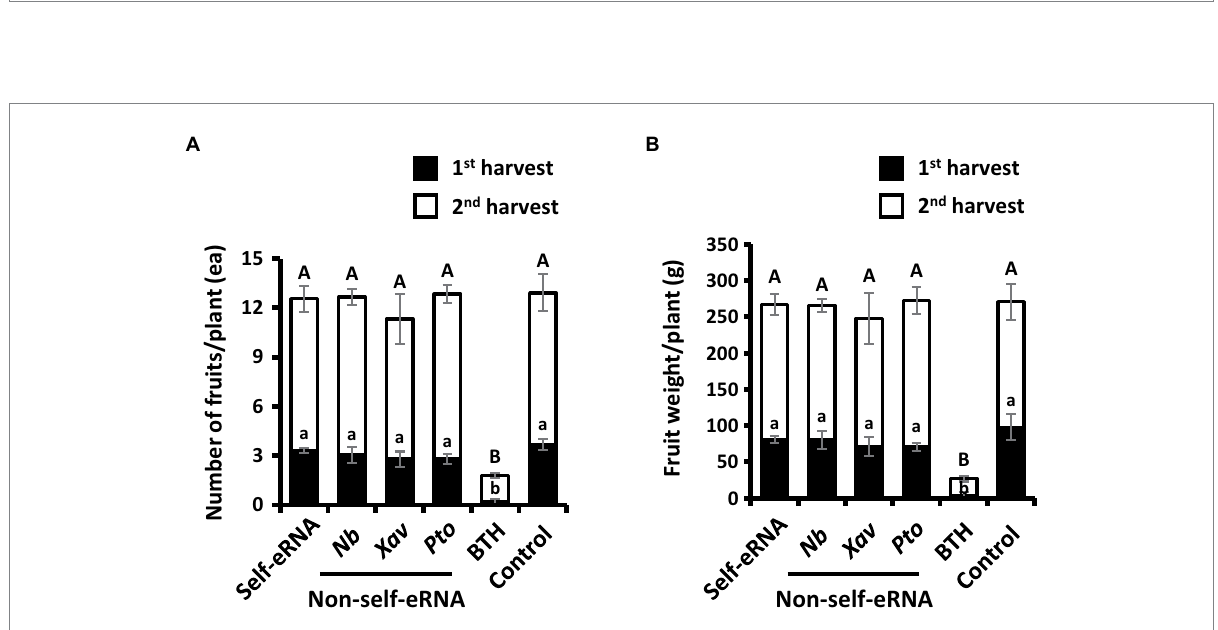
FIGURE 3 Effect of self- and non-self-eRNAs on pepper marketable yield. a, b Fruit number (A) and fruit weight (B) per plant treated with self-eRNA derived pepper and non-self-eRNA that including N. benthamiana (Nb) , X. axonopodis pv. vesicatoria (Xav) , and P. syringae pv. tomato (Pto) , 1 mM BTH, and control. Fruit number and weight were measured in the second round of harvest at 80 and 90 days post-infiltration, respectively. Data represent mean ± SEM. Different letters indicate statistically significant differences between control and other treatments ( p = 0.05; LSD